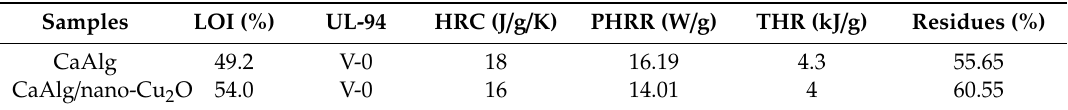
Table 2. Limiting oxygen index (LOI) test, UL-94 test and MCC test results of CaAlg and CaAlg / nano-Cu 2